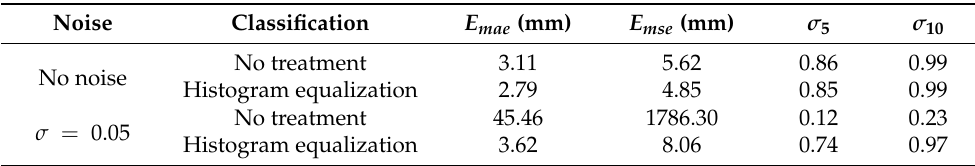
Table 1. Error indicators (histogram equalization). Noise